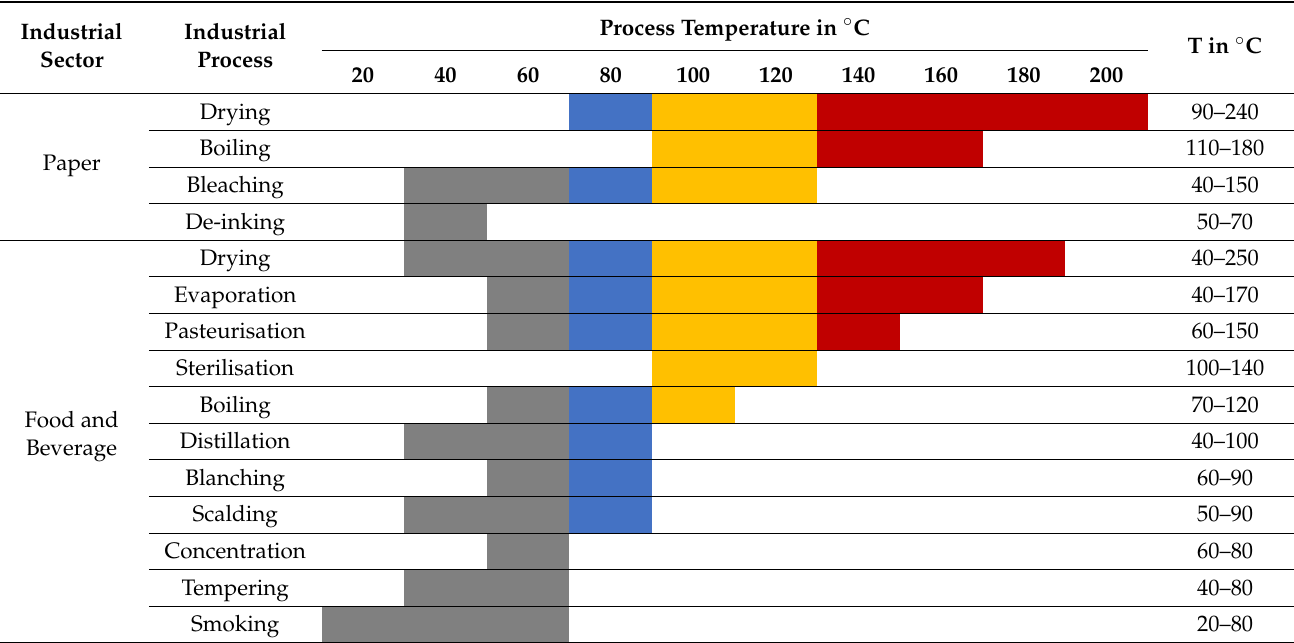
Table 3. Overview of heat-pump applications and temperature ranges in selected industrial